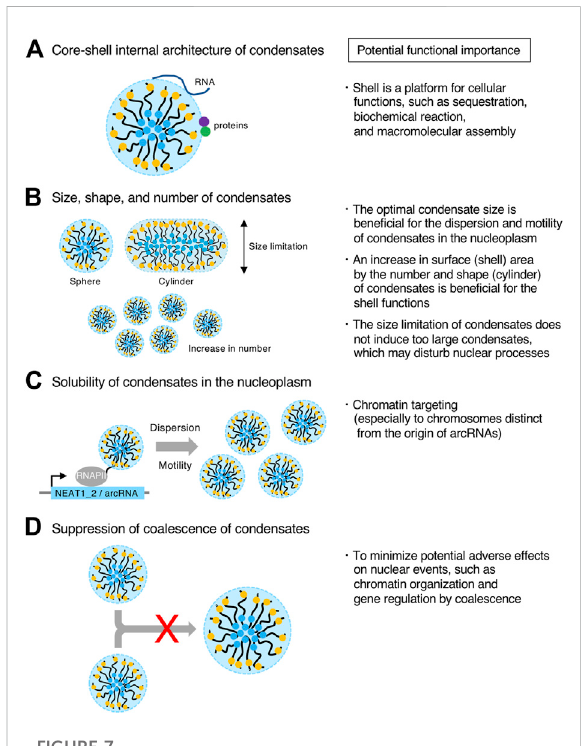
FIGURE 7 Potential functional importance of micellization. (A – D) Features of condensates formed through micellization are shown (Left). Potential functional importance related to the features on the left is listed